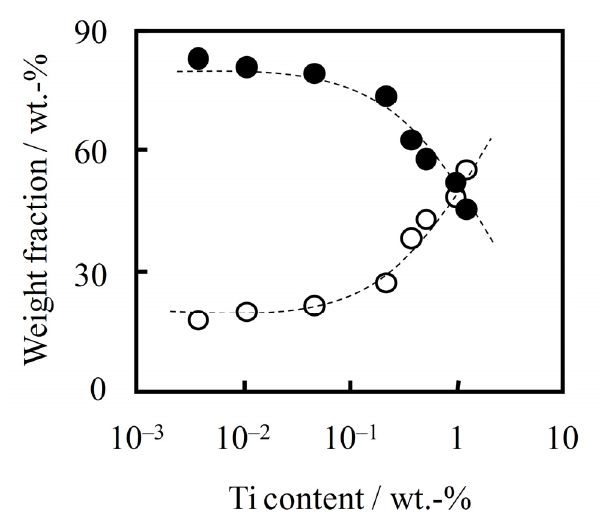
Figure 3. Weight fractions (( ○ ) hexane-insoluble [HI] and ( ● ) hexane-soluble [HS]) after fractionation of PPs produced by the model catalysts at different Ti